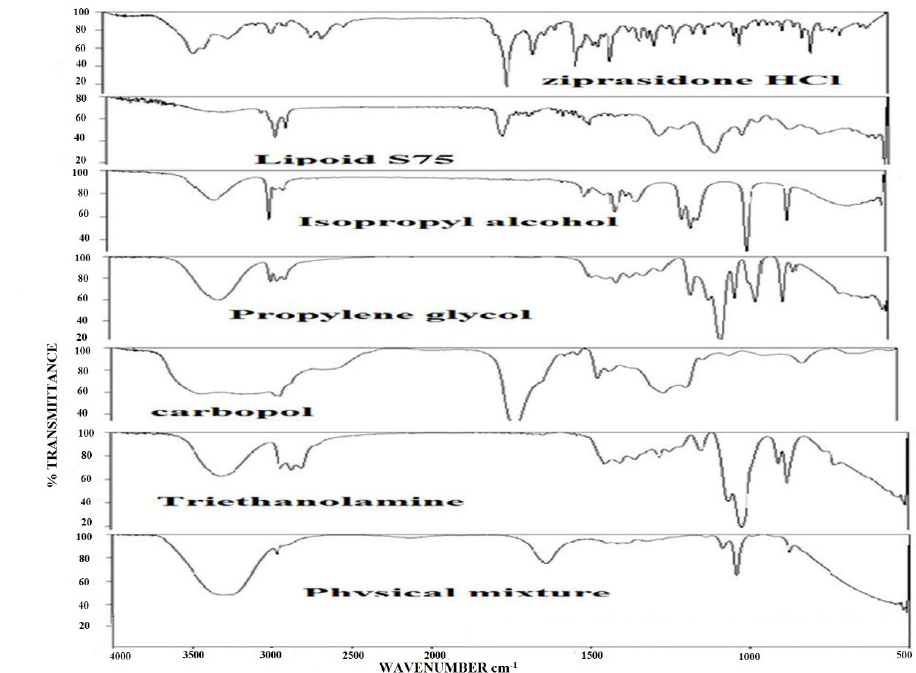
FIGURE 1 - The overlap infrared spectrum of ziprasidone HCl, excipients and physical